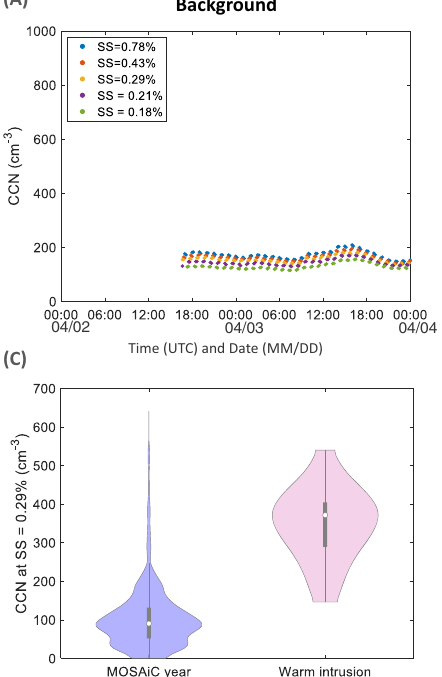
areacombinationofboxplotand akerneldistributionfunctiononeachsideofthe boxplots. The white circles de fi ne the median of the distribution and the edges on the inner grey boxes refer to the 25th and 75th percentiles. Both CCN and particle concentration data are cleaned from ship exhaust emissions via applying the pol- lution mask (see Methods section; subsection measurement of total particle con- centration). CCN data include Nov. 1, 2019 to May 9, 2020 and CPC data